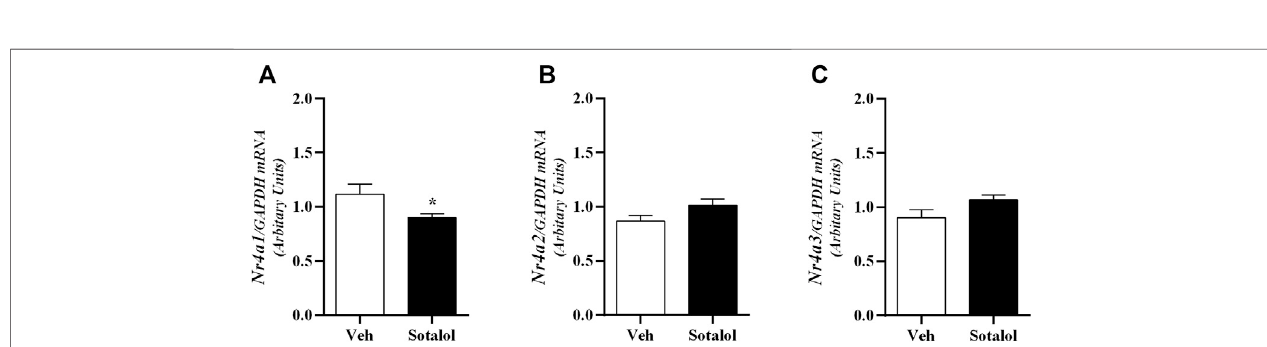
FIGURE 8 | Hippocampus mRNA expression of (A) Nuclear receptor 4 ( Nr4 ) a1 ; (B) Nr4a2 , and (C) Nr4a3 on day 14 of post-traumatic stress disorder (PTSD) induction. Values are means ± SEM of 6-7 mice per group. Results of mRNA are expressed as arbitrary units (AUs) after normalization for glyceraldehyde 3-phosphate dehydrogenase (GAPDH). Veh, vehicle-treated PTSD mice; Sotalol, sotalol-treated PTSD mice. *, signi fi cantly different from correspondent values in vehicle-treated PTSD mice ( p ˂ 0.05).